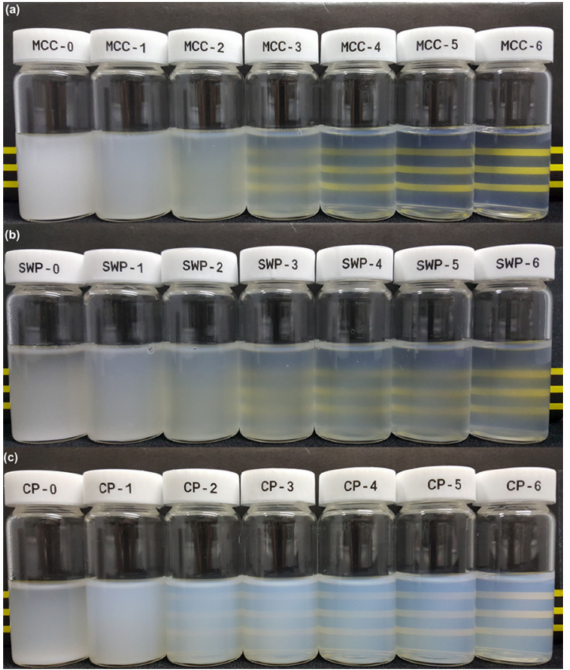
Figure 3. Photograph of CNCs suspensions with changing turbidity due to increased mechanical treatment: ( a ) CNCs (MCC), ( b ) CNCs (SWP), ( c ) CNCs